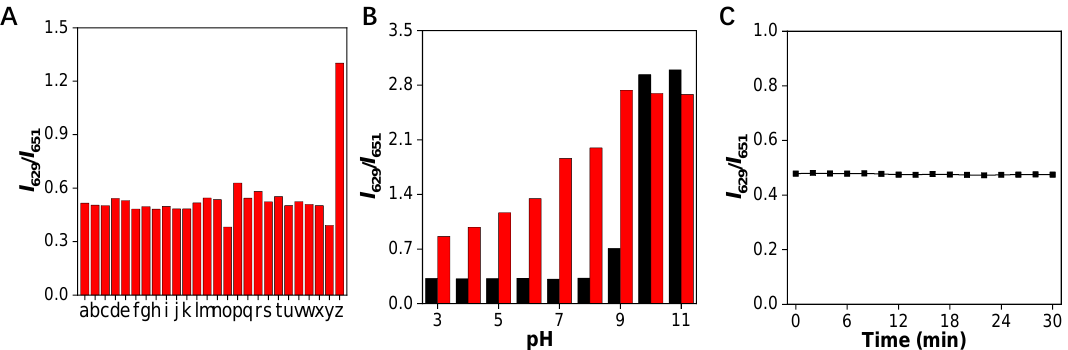
Figure 4. ( A ) Variation of the relative PL intensity ratios ( I 629 / I 651 ) of TCFISE (5 μM) after incubation with 200 mU/mL of CaE and other biologically relevant substances. a: AcO − (20 mM); b: Al 3+ (20 mM); c: Ca 2+ (20 mM); d: Cu 2+ (20 mM); e: Fe 3+ (20 mM); f: K + (20 mM); g: Mg 2+ (20 mM); h: Na + (20 mM); i: NH 4+ (20 mM); j: NO 2 − (20 mM); k: ClO − (2 mM); l: H 2 O 2 (2 mM); m: O 2 − (2 mM); n: Vc (2 mM); o: BSA (100 μg/mL) ; p: Cys (10 mM); q: GSH (10 mM); r: Hcy (10 mM); s: L -glutamine (10 mM); t: Pro (10 mM); u: tyrosinase (200 mU/mL); v: acid phosphatase (200 mU/mL); w: lipopolysaccharide (50 μg/mL) ; x: glucose (10 mM); y: acetylcholine esterase (200 mU/mL); z: CaE (200 mU/mL). ( B ) Relative PL intensity ( I 629 / I 651 ) of TCFISE (black bars) and TCFISE + CaE (red bars) in buffers of different pH. ( C ) Photostability of TCFISE. λ ex = 575 nm.